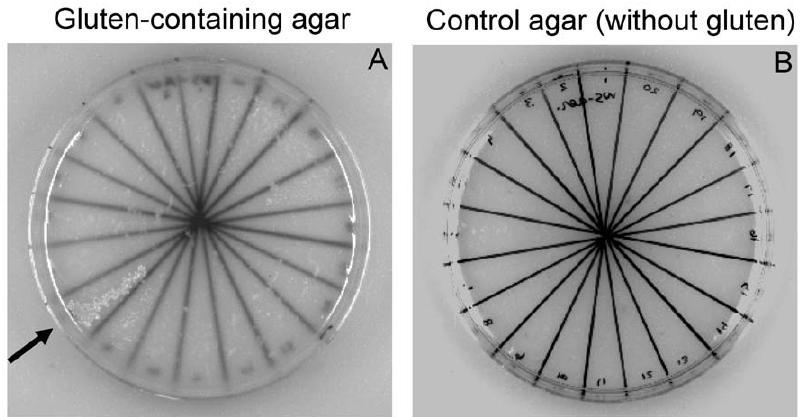
Figure 1. Assessment of bacterial growth on gluten-limited agar. Twenty different microbial strains collected from dental plaque were cultured on agar media containing gluten as the sole protein source (GA, left) and on the same agar formulation not containing gluten (control, right). After 24 h incubation, among these twenty analyzed strains, one strain (WSA-8) was found to be capable of growing on the gluten agar (indicated by an arrow). Note the presence of small, undissolved gluten particles appearing as white flakes in the gluten